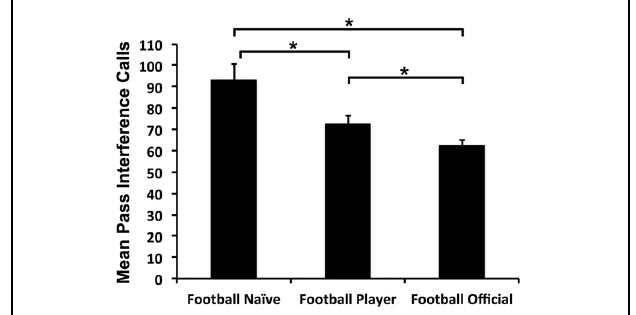
FIGURE 1 | Average number of pass interference calls for each group. ∗ p < 0.05.